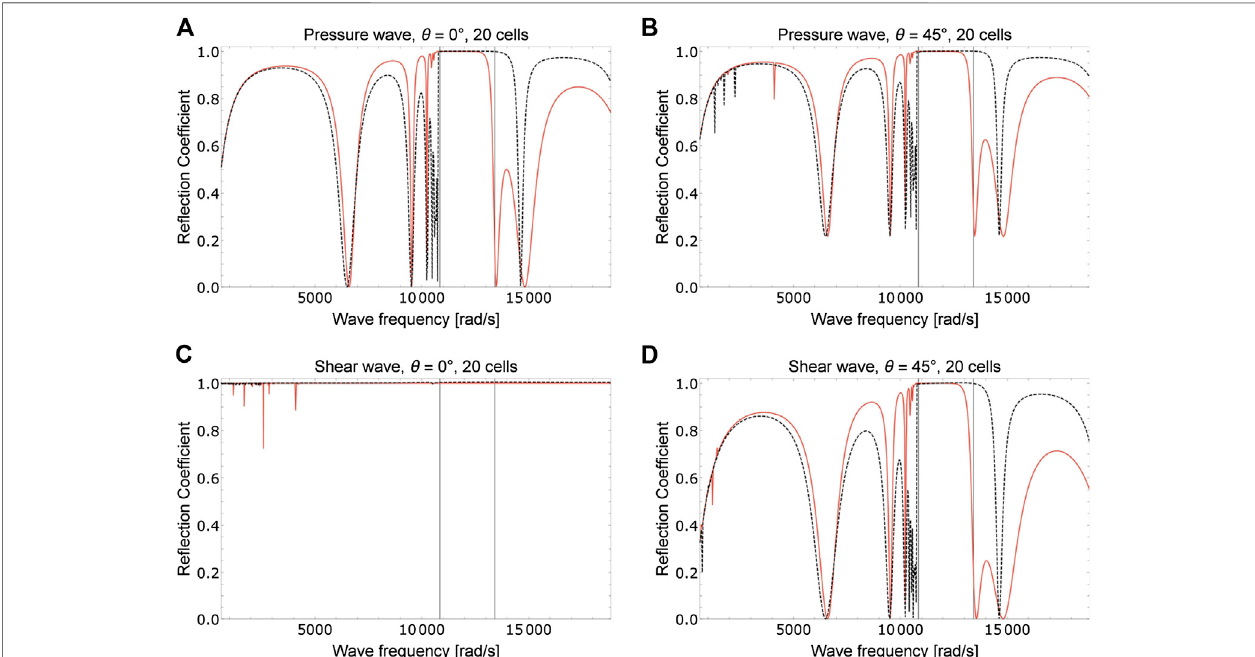
FIGURE 7 | Comparison of the microstructure ’ s (black line) and micromorphic (red line) re fl ection coef fi cient as a function of frequency for a 20 unit cells slab of MM1 and embedded in CM1 . (A) “ pressure ” normal incident wave with respect to the slab ’ s interface. (B) “ pressure ” 45 ° incident wave with respect to the slab ’ s interface. (C) “ shear ” incident wave normal to the slab ’ s interface. (D) “ shear ” 45 ° incident wave with respect to the slab ’ s interface.